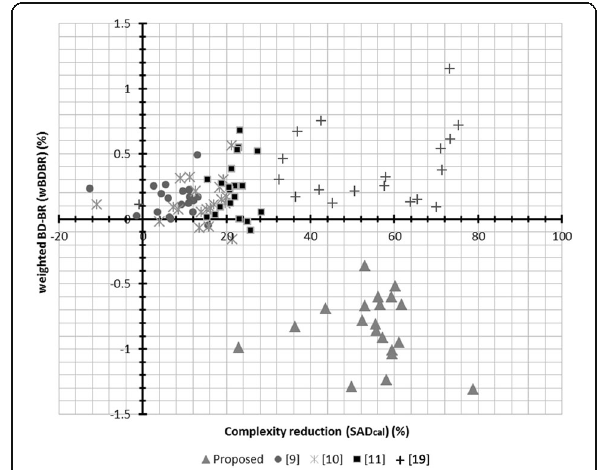
Fig. 12 Performance comparison of the proposed algorithm and previous